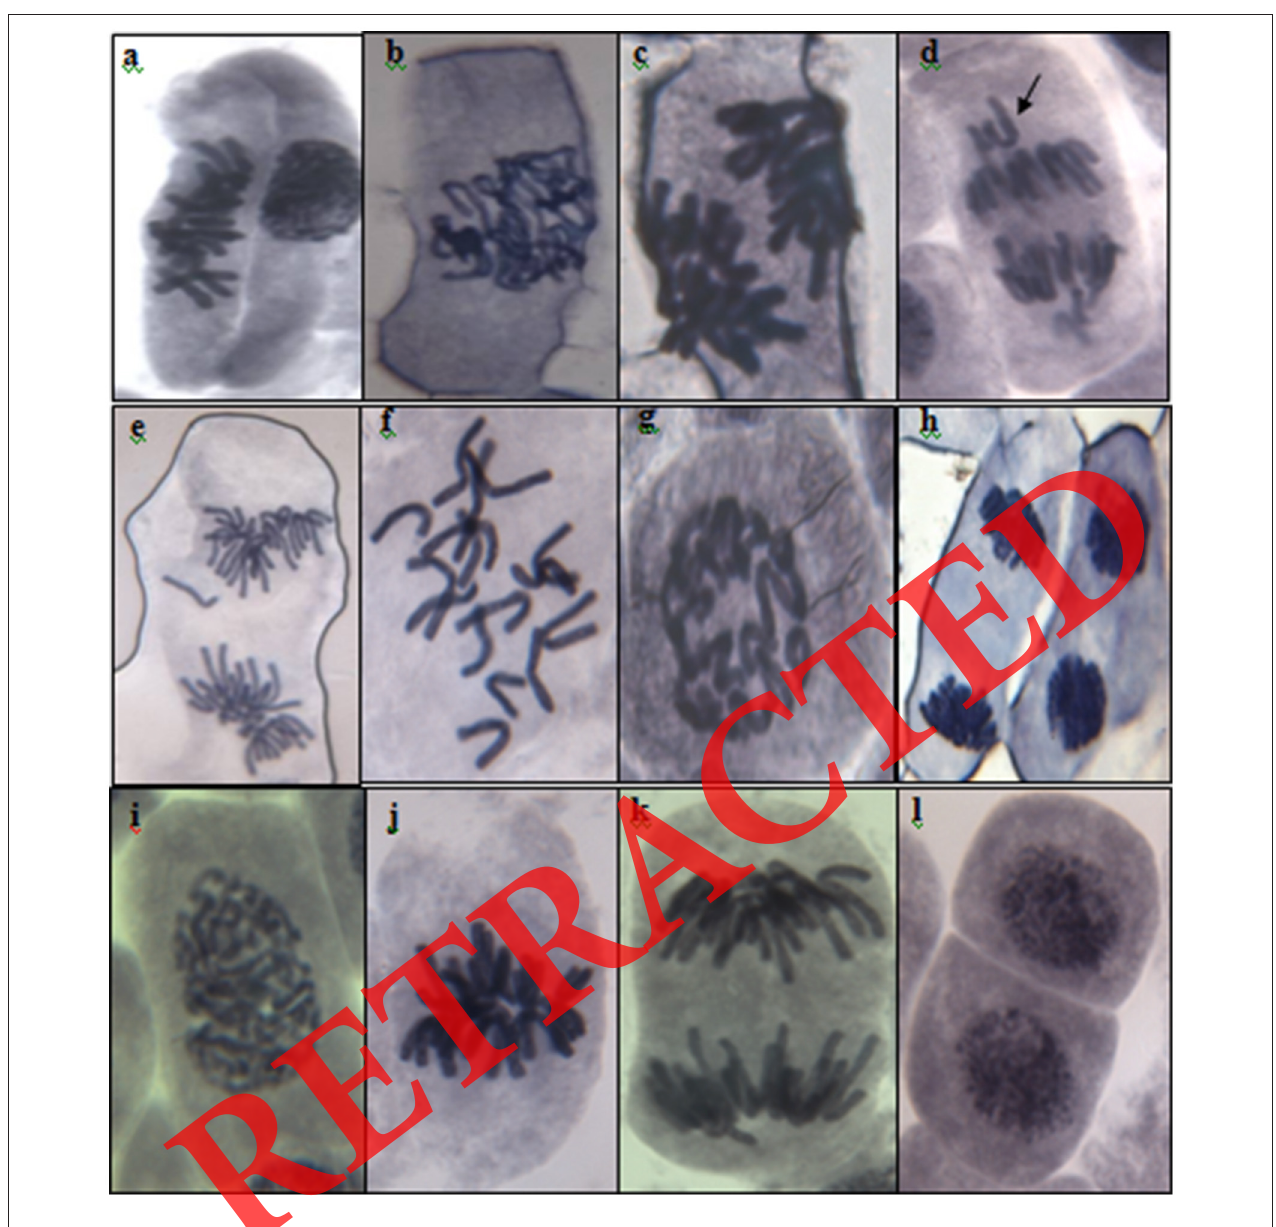
FIGURE 7 | Different chromosomal aberration induced by pulp paper mill effluent before (a–h) and after (i–l) bacterial treatment. (a) disturbed pole to pole arrangement of chromosomes at metaphase (b) vagrant chromosome at metaphase (c) diagonal anaphase (d) arrow shows laggard chromosome (e)